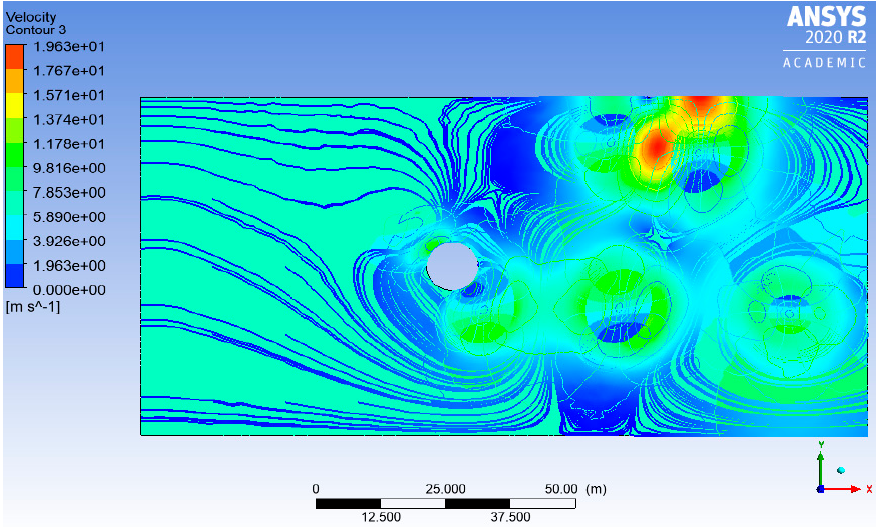
Figure 14. Velocity contour for the flow on the free-floating buoy under 0.45 m/s case.